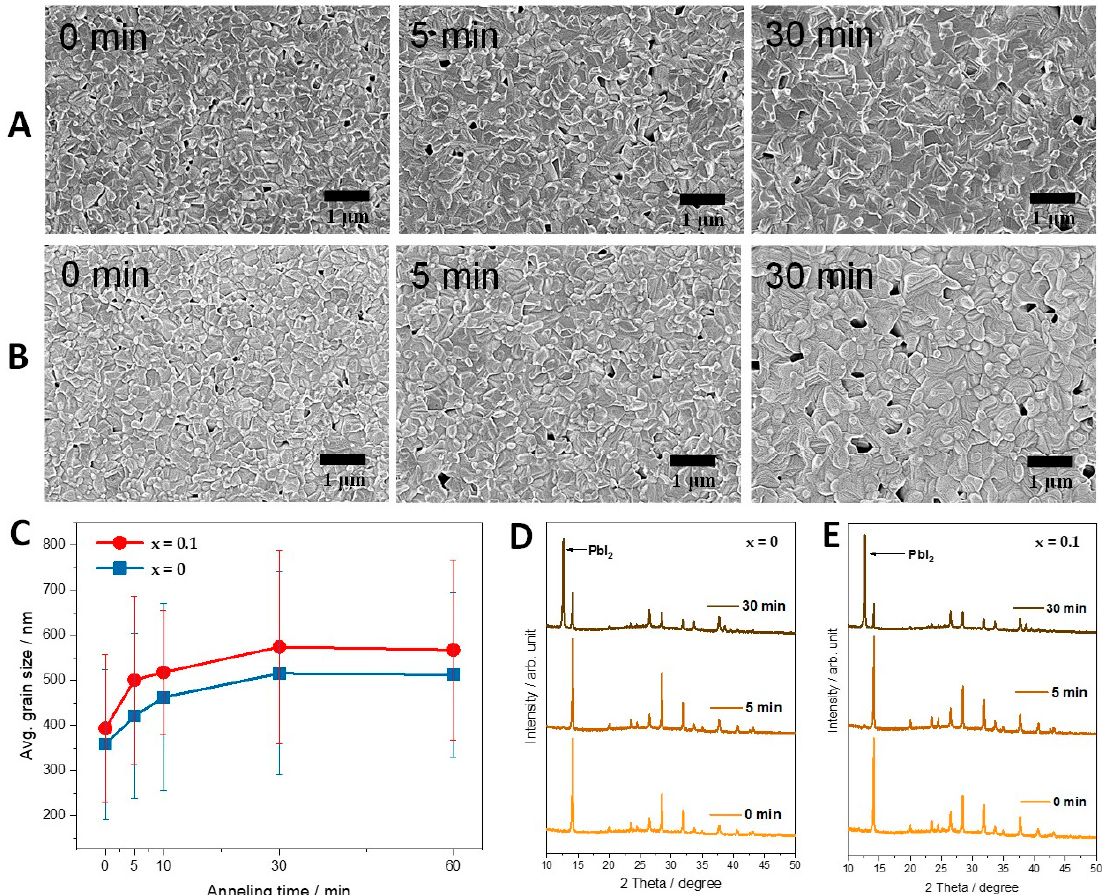
Figure 2. In-situ SEM images obtained by annealing of MAPbI 3 − x Cl x films at 130 ◦ C over a period of time. ( A ) x = 0, ( B ) x = 0.10, and ( C ) corresponding grain size distribution when samples reached and sustained 130 ◦ C. X-ray diffraction results of MAPbI 3 − x Cl x (x = 0, 0.1) annealed at 130 ◦ C with increasing annealing time ( D ) x = 0, ( E ) x = 0.10, respectively.